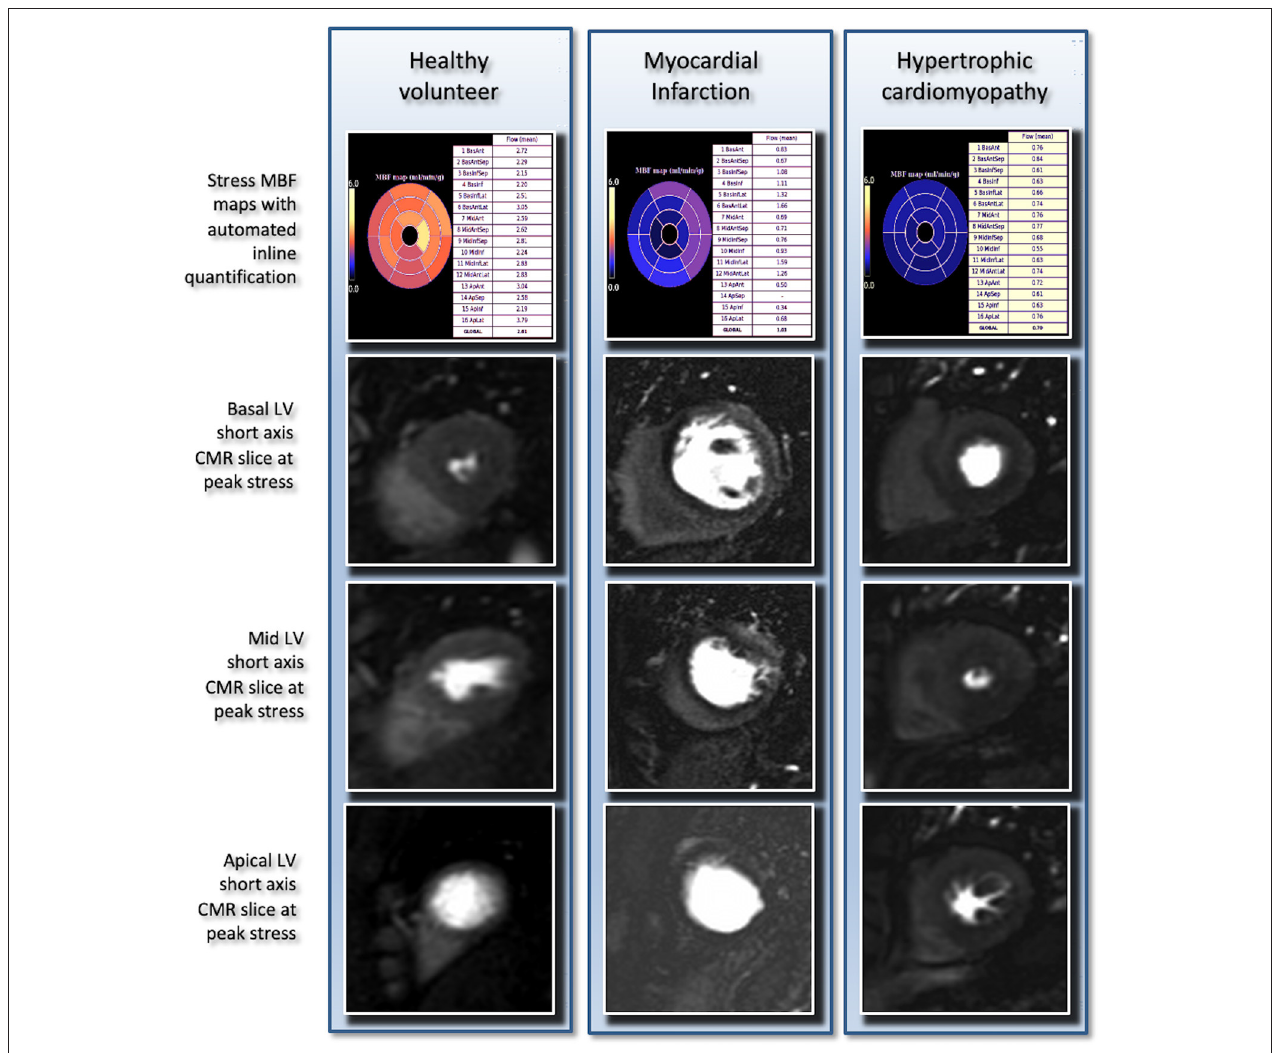
FIGURE 5 | Stress perfusion CMR images obtained by automated in line quantification as well as the basal, mid, and apical slices that were obtained in a healthy volunteer showing no inducible ischaemia, in a patient with a myocardial infarction showing inducible ischaemia in the basal to apical septal and inferior segments and in a patient with hypertrophic cardiomyopathy demonstrating globally reduced myocardial blood flow secondary to severe microvascular